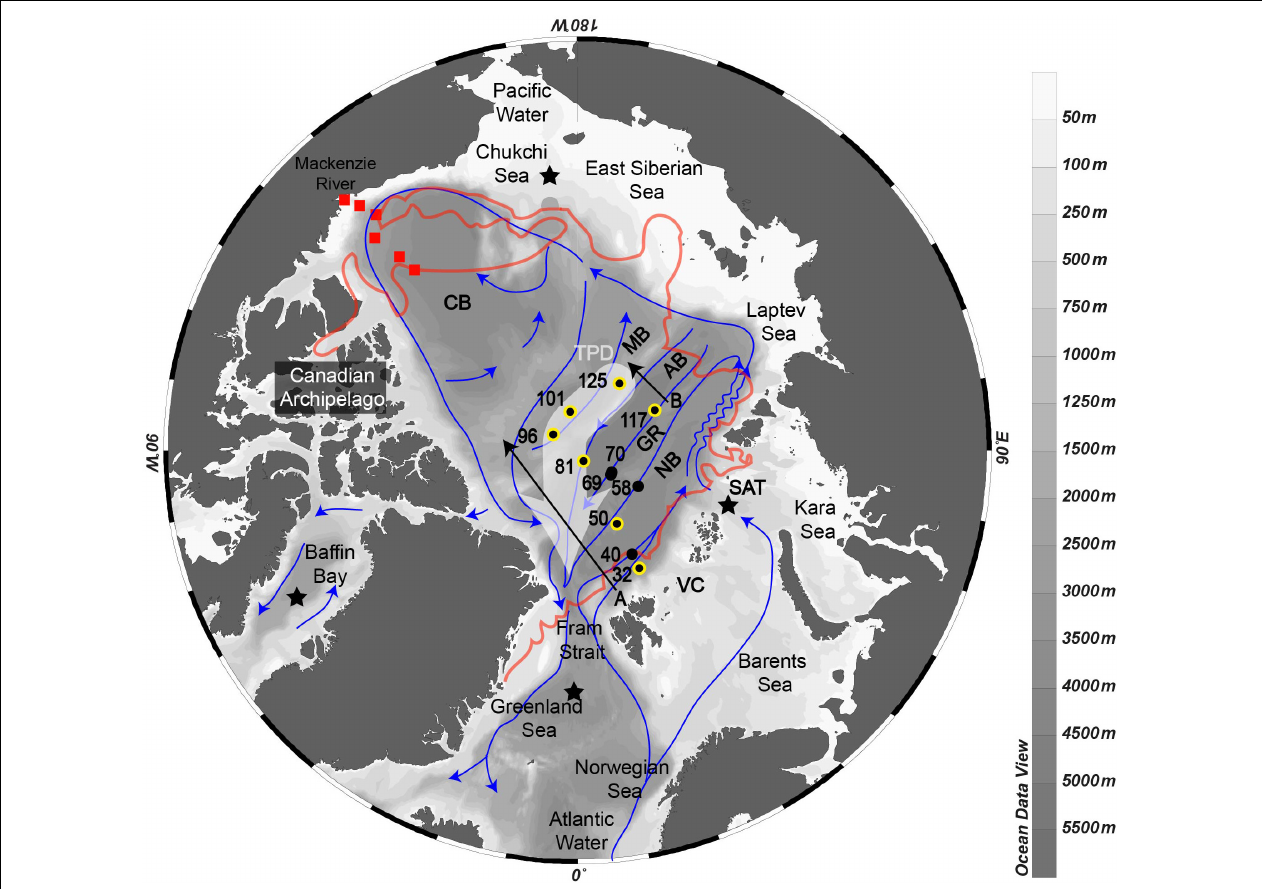
FIGURE 1 | Map of the Arctic Ocean with schematic intermediate and deep circulation (Jones, 2001). Stations from the present study are numbered and colored: black dots represent samples for δ 30 Si-DSi; yellow-black dots represent samples for δ 30 Si-DSi and δ 30 Si-bSiO 2 . Transect A and B marked for further reference. The Transpolar Drift surface current is highlighted with a wide white arrow. The sea ice extension is represented by the red line around the basins. In the Canadian Basin, the stations of Varela et al. (2016) are shown by red squares. The stars provide the approximate main locations of deep water formation areas on the Kara Sea shelf, in the Chukchi Sea, in the Greenland Sea and in the Labrador Sea. NB, Nansen Basin; GR, Gakkel Ridge; AM, Amundsen Basin; MB, Makarov Basin; CB, Canadian Basin; VC, Victoria Channel; SAT, Santa Anna Trough. Map and all following section plots were generated using Ocean Data View (Schlitzer,